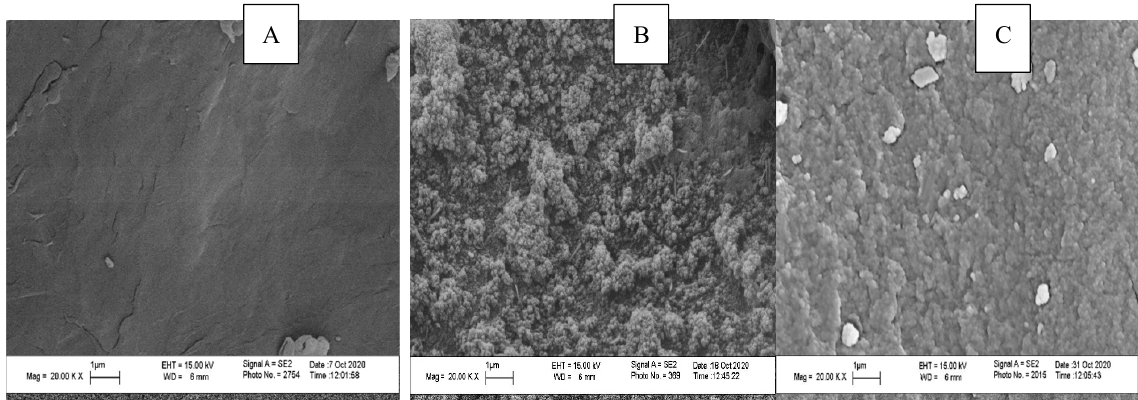
Figure 3. SEM images of chitosan ( A ), La 2 O 3 nanoparticles ( B ), chitosan-La 2 O 3 nanocomposite 15 wt% ( C ).